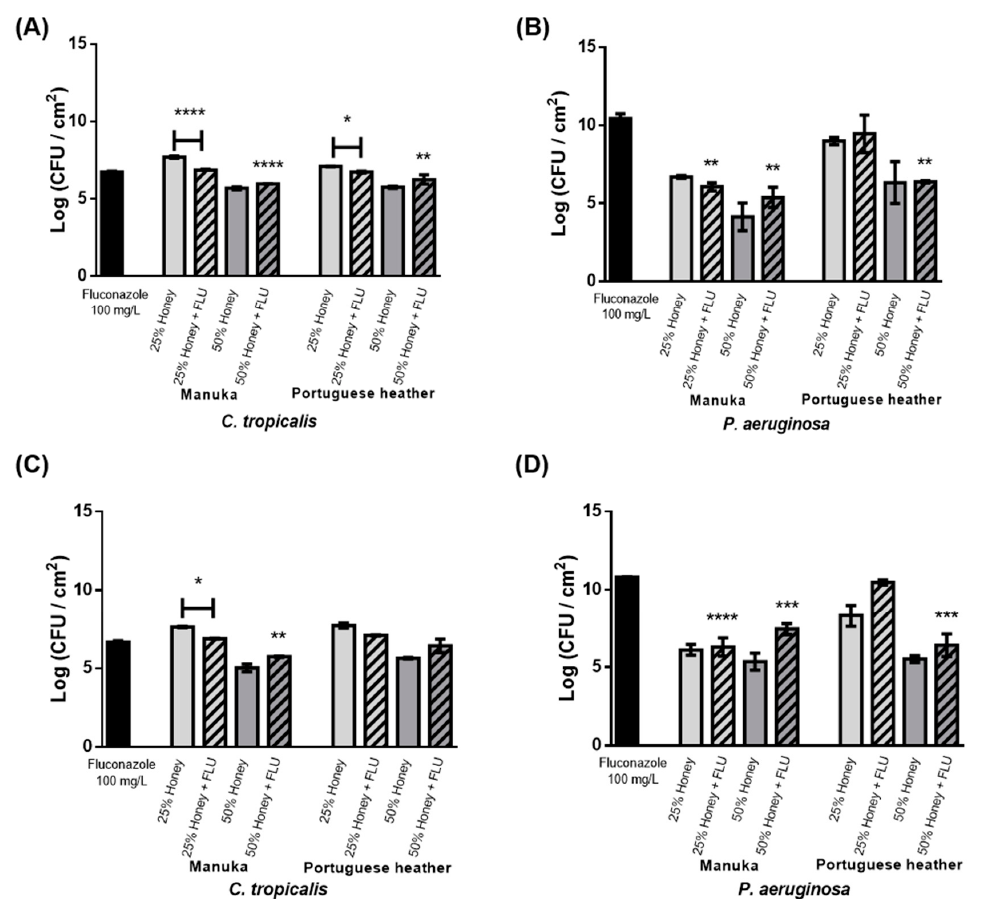
Figure 2. Therapeutic effect of manuka or PH honeys combined with 100 mg L − 1 of FLU on 24 h-old ( A , B ) single- and ( C , D ) dual-species biofilms formed by ( A , C ) C. tropicalis and ( B , D ) P. aeruginosa at 24 h. * p < 0.1, ** p < 0.01, *** p < 0.001, **** p < 0.0001 indicates a statistically different reduction in comparison with the respective control.